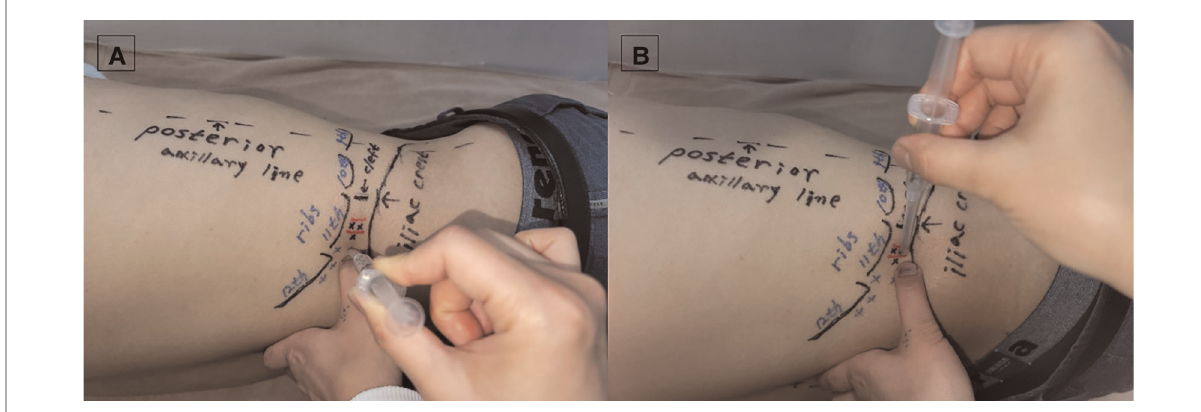
FIGURE 1 Needle entry point and trajectory for the treatment of ( A ) super fi cial and ( B ) deep fi ber trigger points. ( A ) When we targeted the super fi cial fi bers (iliocostal fi bers), palpation was performed slightly obliquely anteriorly (10 – 20°). To prevent pneumothorax, the needle should not cross the contour of the rib or be inserted in the cranial direction. ( B ) When we targeted the deep fi bers (iliolumbar, lumbocostal fi bers) near the cleft, we palpated vertically toward the transverse processes of the lumbar vertebrae. If the needle is inserted too anteriorly or at the ventral position instead of in the cleft between the fi rm or hard back muscle and the soft abdominal muscle, intraperitoneal and retroperitoneal organ injuries can occur; thus, careful needling is required. (The model in Figure 1. is one of the authors of this